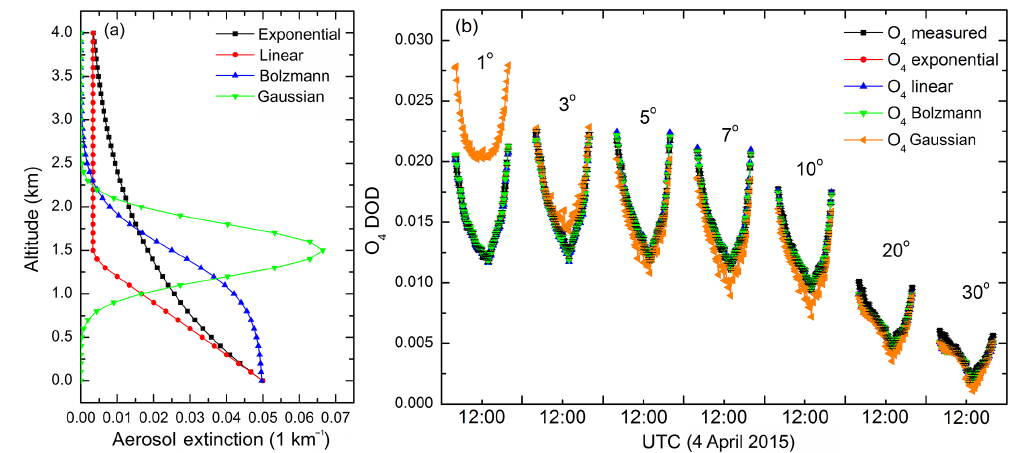
Figure 3. Different a priori aerosol extinction profiles as input (a) and relevant O 4 DODs simulation compared with measured O 4 DODs on 4 April 2015 (b) .